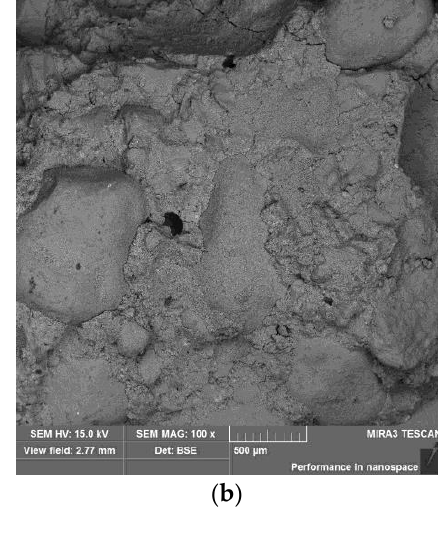
Table 6. Water extract of selected components of mixtures, in mg/dm 3 .